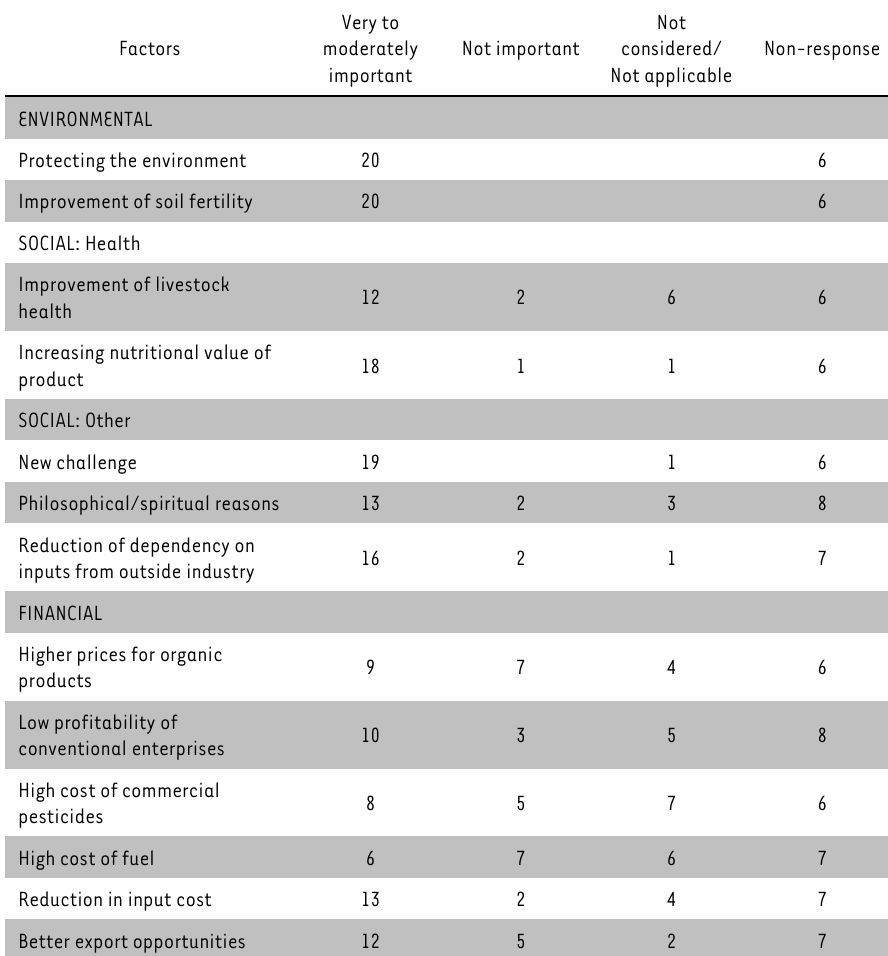
Motivational factors to convert to or use organic